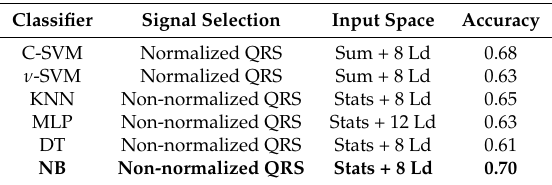
Table 4. Accuracy value for the best pairs of signal selection and input space for each classifier over the HCM database.